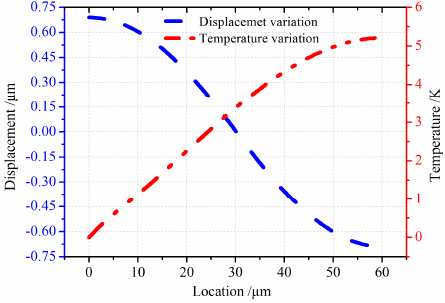
Figure 10. The path analysis results of temperature and displacement variation.